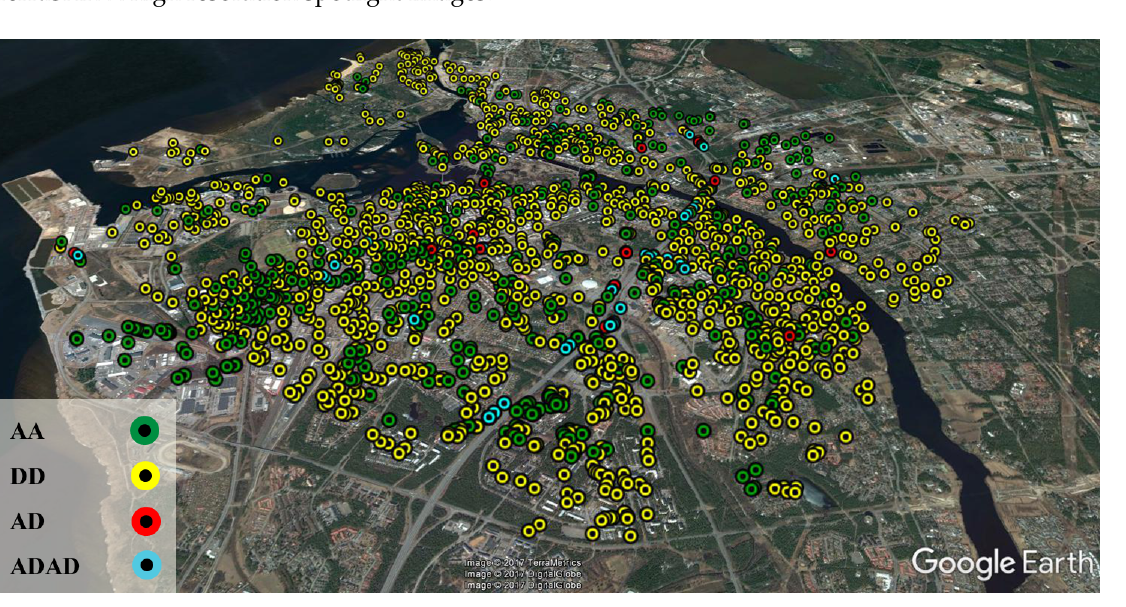
Figure 15. Total number of 2049 GCPs in Oulu, color-coded based on the geometry configuration used for their positioning (AA: ascending-ascending, DD: descending-descending, AD: ascending-descending and ADAD: quad geometry) [89]. The underlying optical image is taken from Google